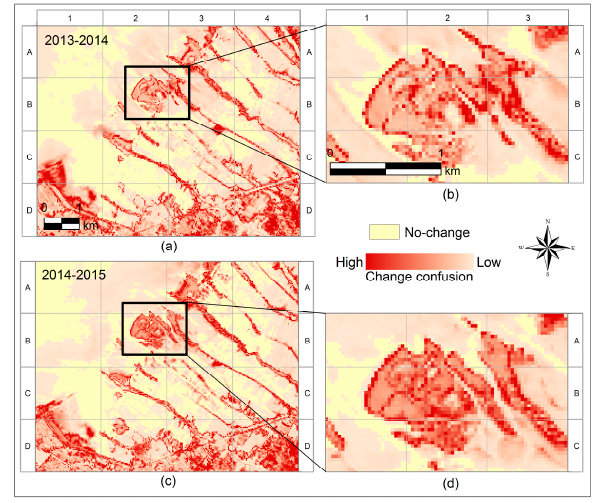
Figure 6. The fuzziness of the shoreline is represented by change confusion values in the periods: 2013–2014 ( a , b ); and 2014–2015 ( c , d ). The change confusion values vary from high values represented by dark orange pixels up to low values represented by light orange pixels, whereas light yellow pixels show the no-change areas.